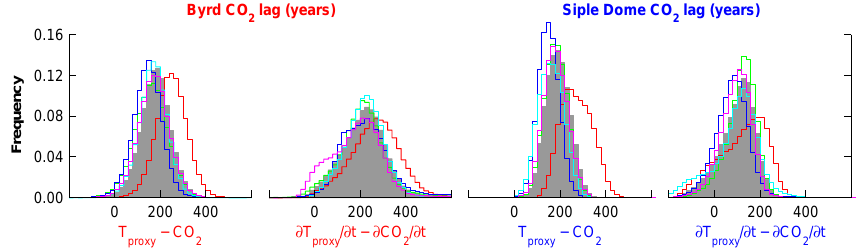
Fig. 2. Lag histograms for the two methods of determining the lag of atmospheric CO 2 after regional Antarctic temperature changes (direct correlation and correlation of derivatives), using each of the two CO 2 data sets (Byrd and Siple Dome). The gray background histograms are based on the complete T proxy composite, the same as in Fig. 1b. The superimposed curves show the corresponding lag histograms when excluding in turn each of the 5 records from the T proxy composite (jack-knifing): excluding Siple (red), excluding Law Dome (green), excluding Byrd (blue), excluding EDML (cyan), and excluding Talos Dome